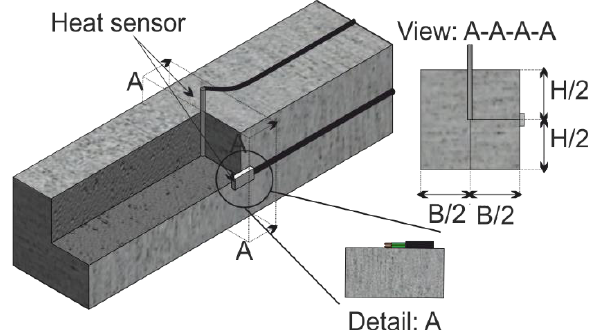
Figure 1. Experimental set-up for the temperature measurement.